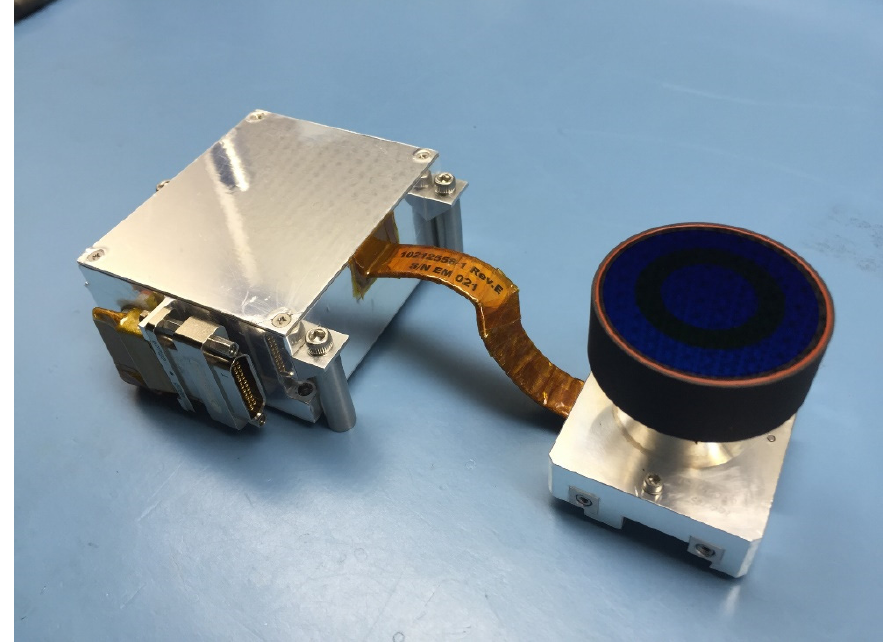
Figure 9. RDS-SkyCam flight model (FM) pre-integrated in the RDS